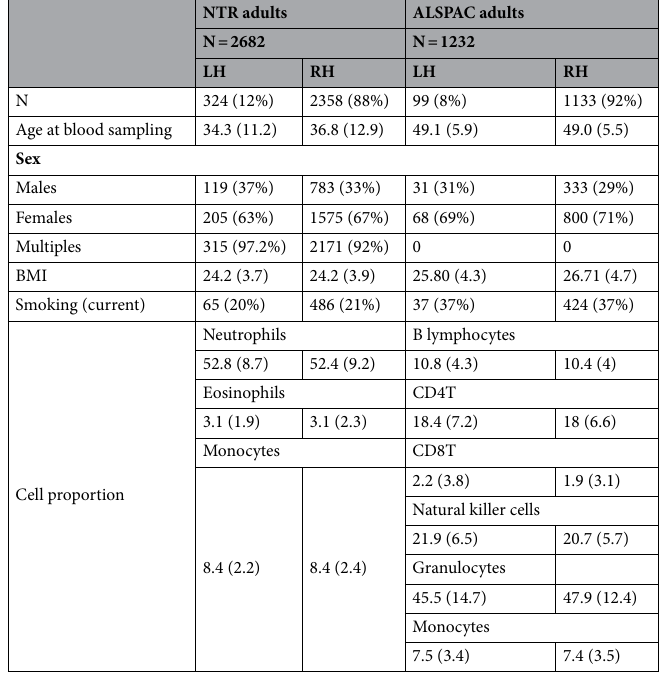
Table 1. Characteristics of adult cohorts included in the primary meta-analysis. NTR Netherlands Twin Register, ALSPAC Avon Longitudinal Study of Parents and Children, LH left-handed, RH right-handed. Whole blood DNA methylation (Illumina 450 k). Numbers in EWAS basic models are reported. Values are presented as mean (standard deviation (SD)) or n (%). Current smokers in ALSPAC were defined as those with cg05575921 methylation below 0.82 (see “Methods”section).